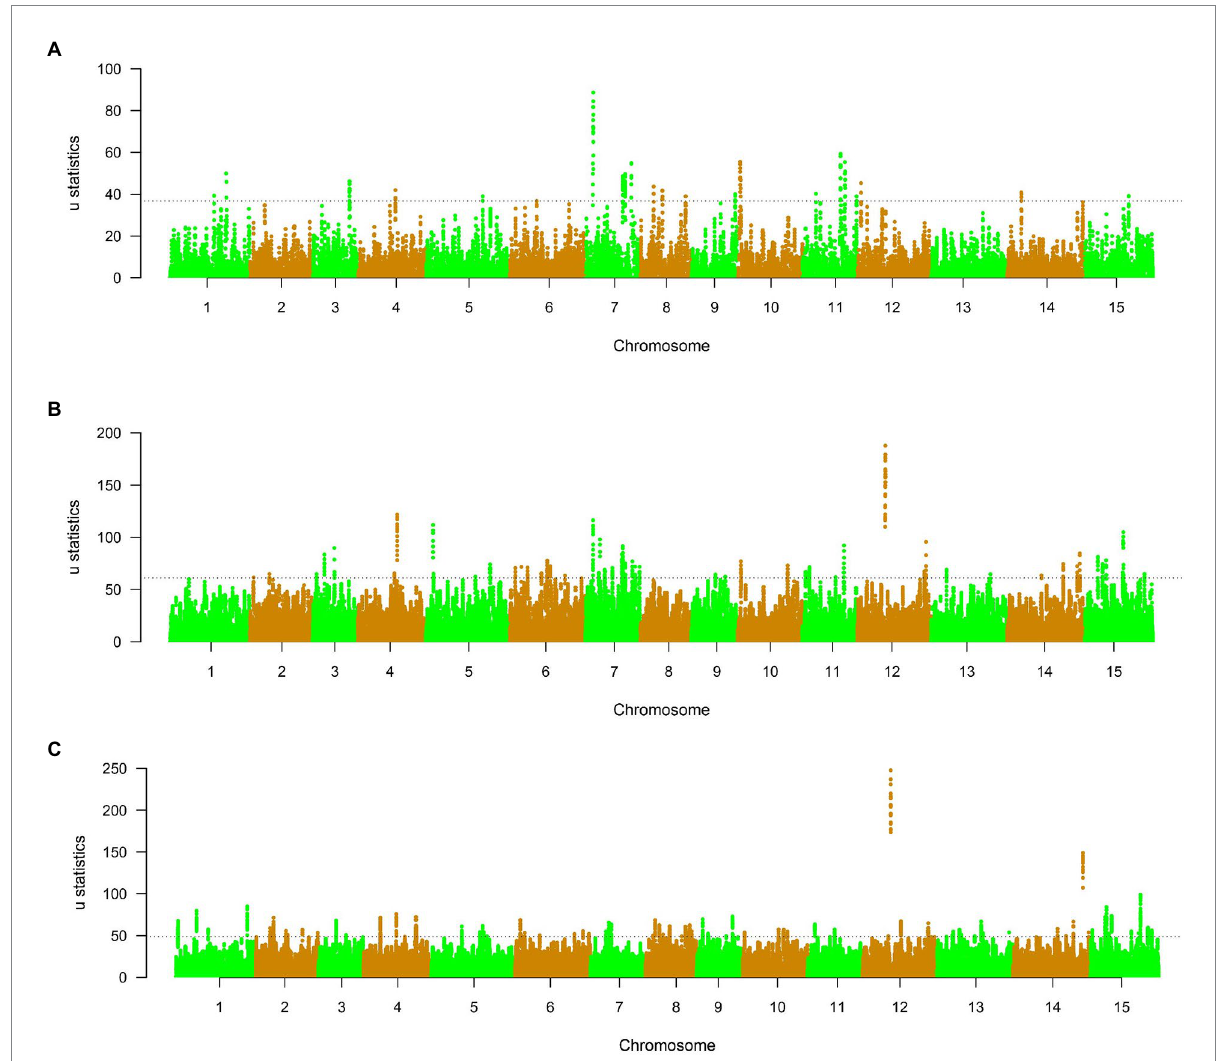
FIGURE 6 (A–C) μ statistics calculated by RAiSD across the genome in different tea plant subpopulations. The dashed lines mark the regions at the top